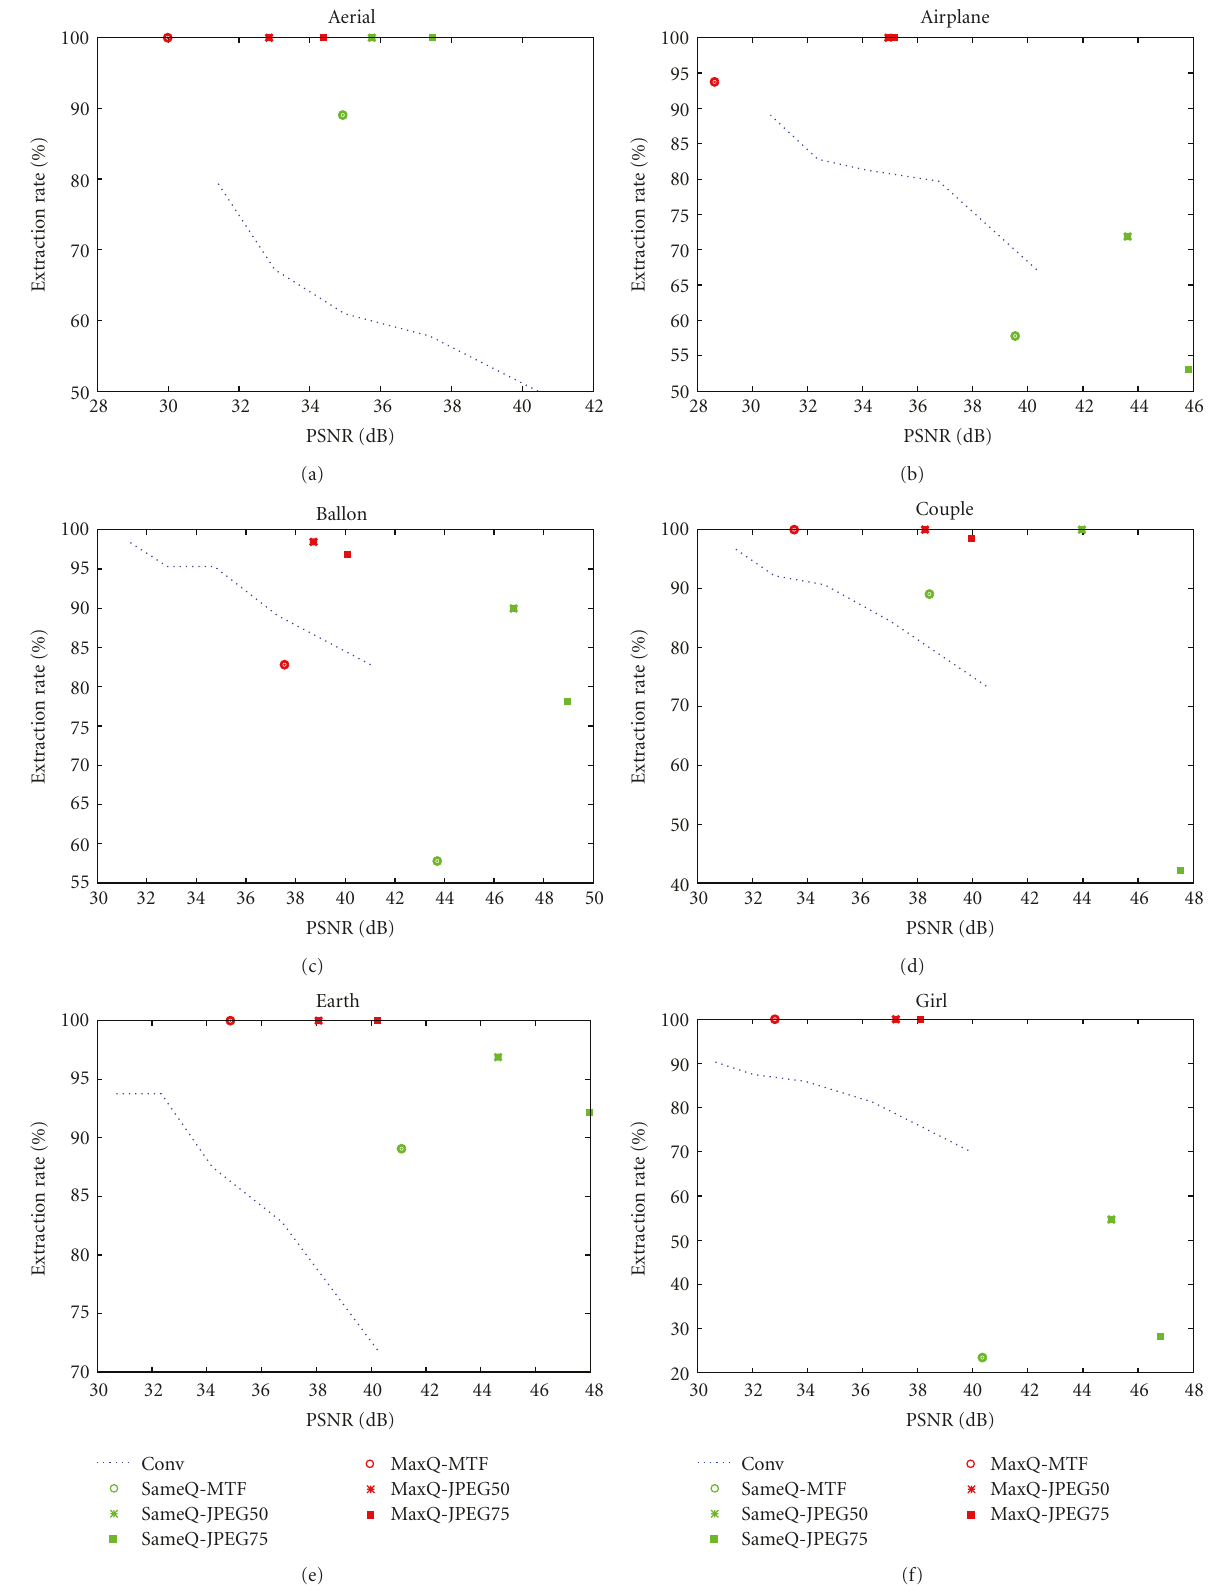
Figure 18: Comparison in the robustness against JPEG compression of quality 90%